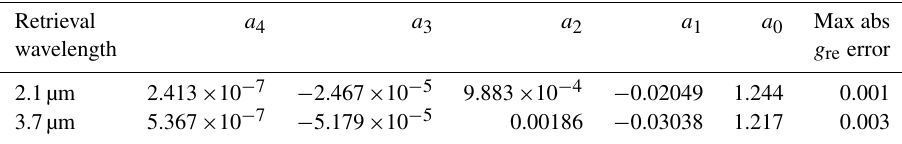
Table 1. Coefficients for the fitting curve (Eq. 14) to estimate the median g re value as a function of τ . The maximum absolute error between the fit and the median line is also shown.